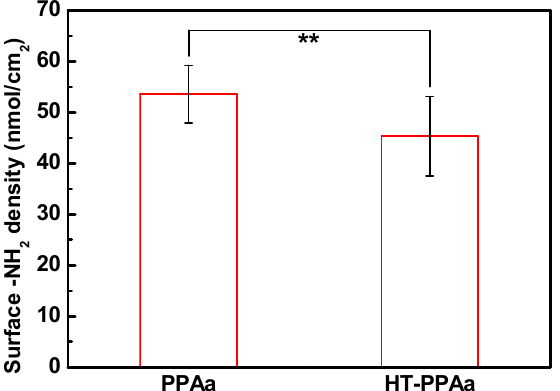
Figure 5. Surface -NH 2 density of the PPAa and HT-PPAa samples. Data are presented as mean ± SD ( n = 4) and analyzed using one-way ANOVA (* p < 0.05, ** p < 0.01, *** p < 0.001).